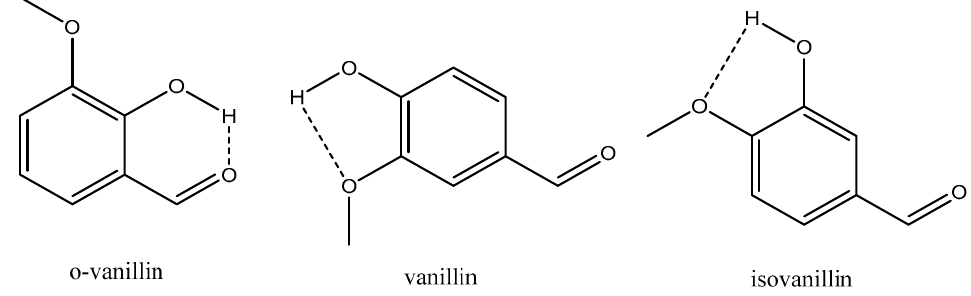
Figure 3. Intramolecular H-bonds of o-vanillin, vanillin and isovanillin. Dashed line illustrates H-bond.